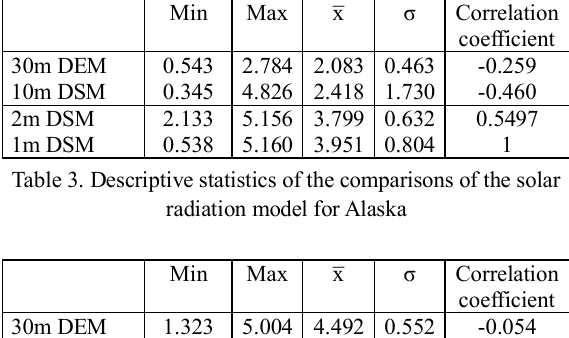
Figure 9. Solar radiation model derived from 2m DSM (top); Solar radiation model derived from 1m DSM (bottom) Processing the 10m DSM is fast, but the disadvantage of the solar radiation model derived from this model is that the solar radiation for individual dwellings cannot be derived, because more than one dwellings may exist within a 10m × 10m area (cell).